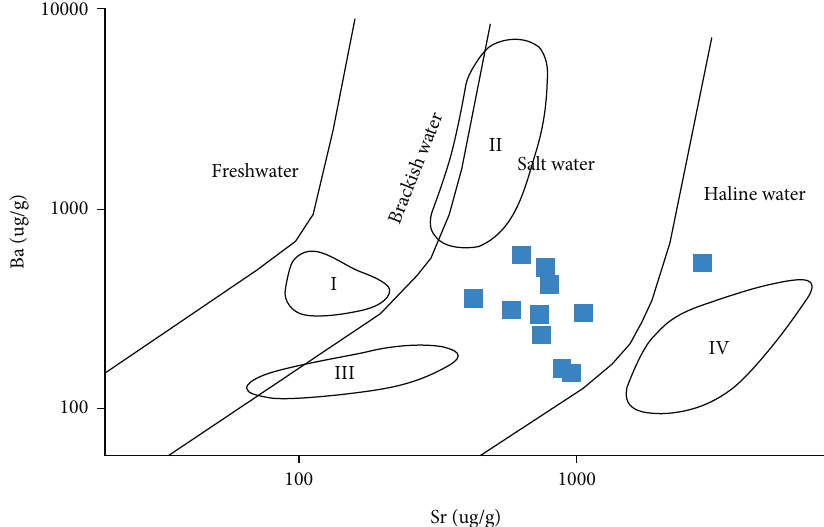
Figure 5: Ba-Sr map of shales in the fi rst member of Luzhai formation in Rongshui area [35]: I stands for modern delta brackish clay area; II represents the Paci fi c o ff shore sediment area; III represents marine carbonate rock area of di ff erent ages in Russian platform; IV represents modern high salt water sediment